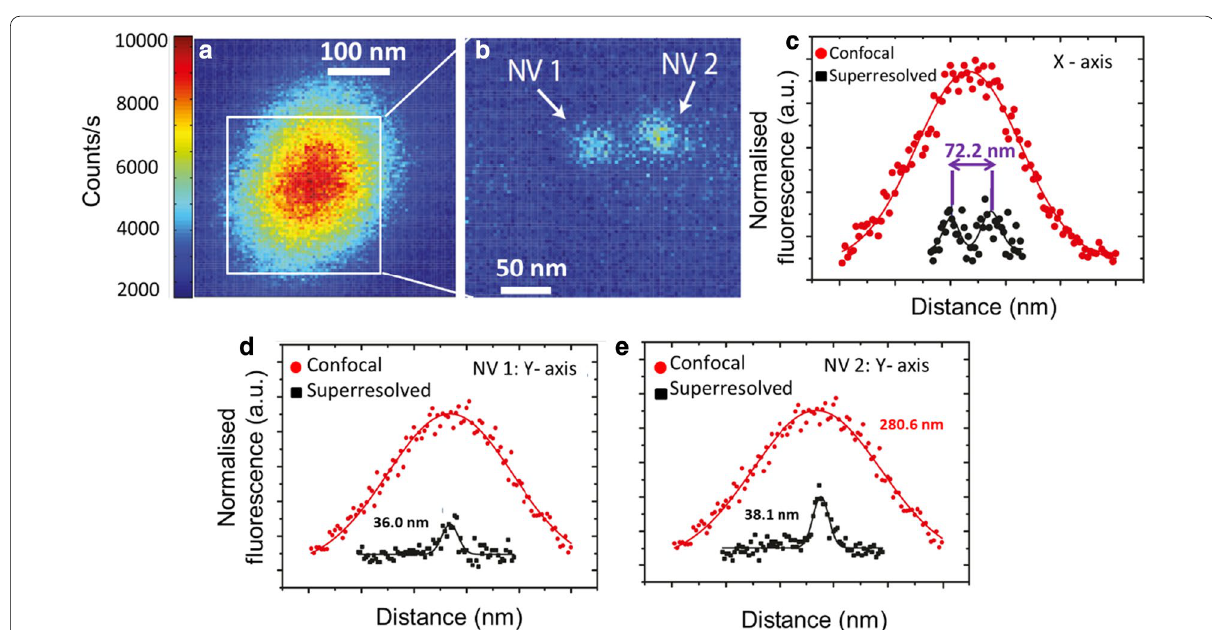
Fig. 4 a Confocal fluorescence map of 500 500 nm (dwell time 2 ms and 1 nm pixel size) and b super-resolved image 300 × white square in (dwell time 24 ms and 1 nm pixel size) b of two NV − centres. The individual confocal spot is super-resolved into two separate dim fluorescence spots. c Cross section along the X-axis showing the separation of 72 nm between the two peaks corresponding to the locations of the centre-to-centre distance of the two NV centres. d Cross sections along the Y-axis with a measured FWHM resolution of 36 nm and 38 nm, corresponding to NV − 1 and NV − 2 in b ,